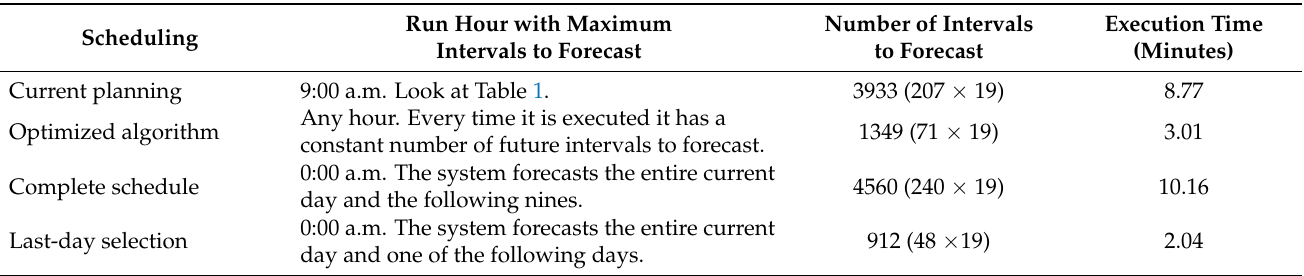
Table 5. Maximum execution